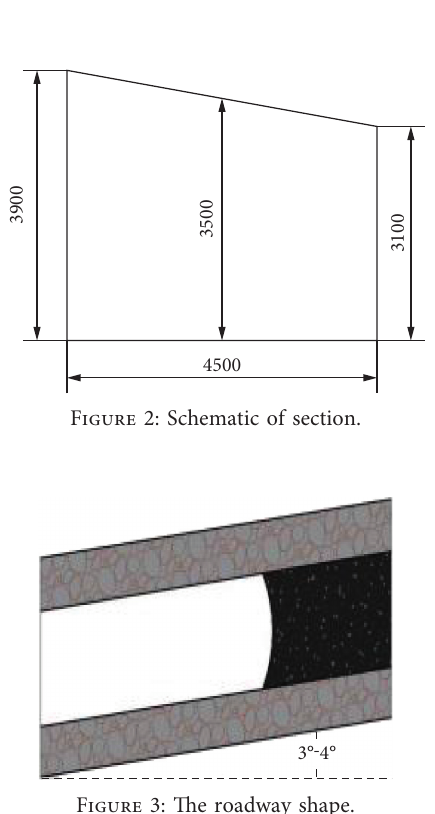
Figure 1: The technical scheme of this health state analysis method.